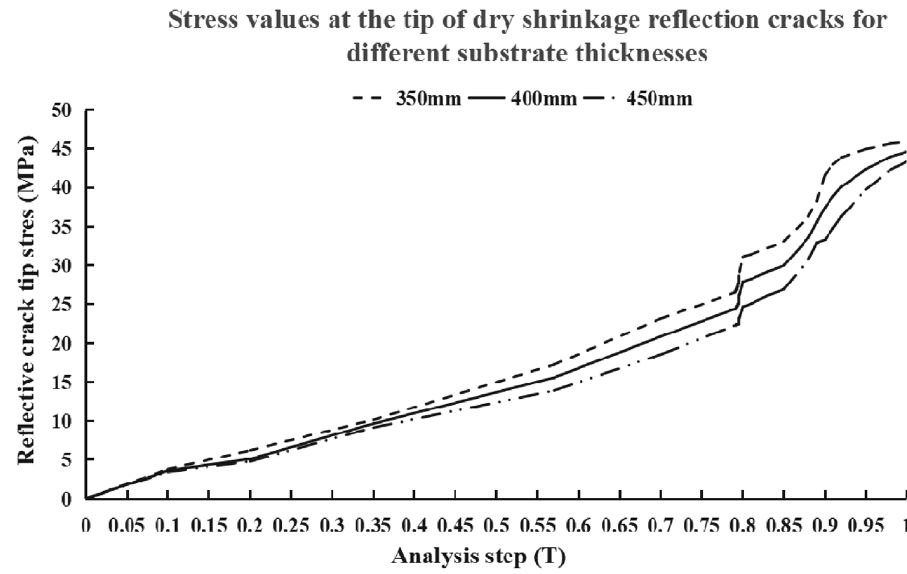
Fig. 10 Stress values at the tip of dry shrinkage reflection cracks for different substrate thicknesses